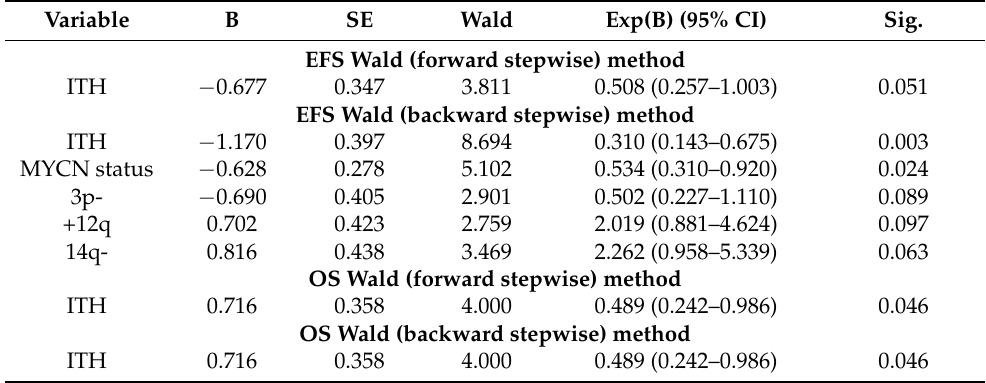
Table 4. Cox regression tests results after applying stepwise forward and backward Wald